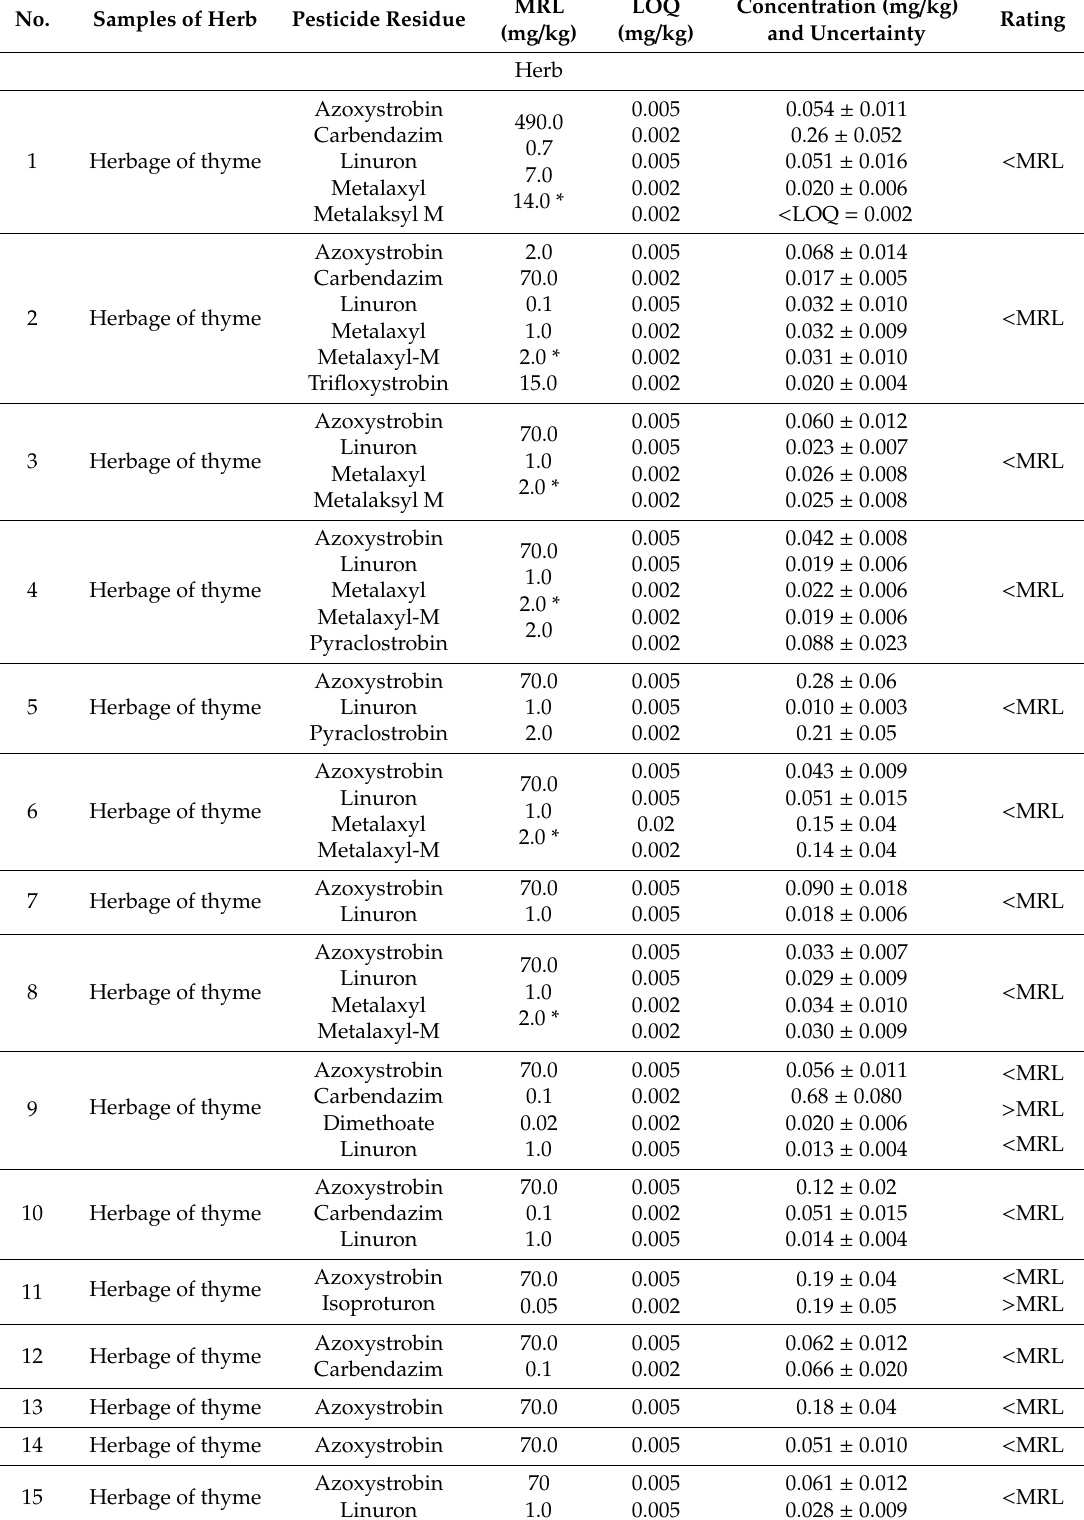
Table 2. Pesticide residue concentrations in examined food